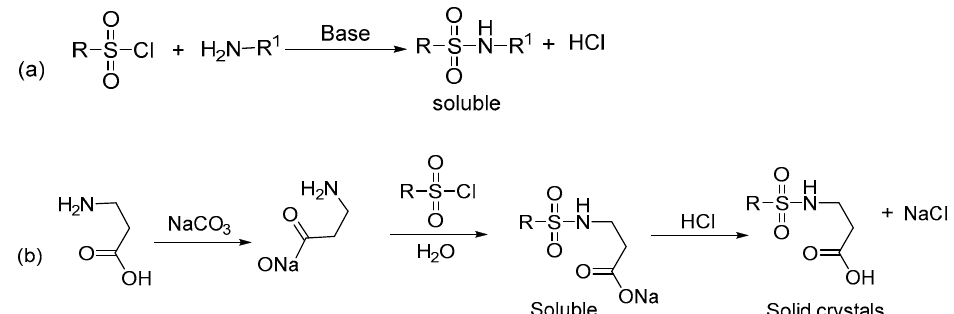
Figure 1. synthesis of sulfonamide using ( a ) direct and ( b ) indirect approaches. Figure 1. Synthesis of sulfonamide using ( a ) direct and ( b ) indirect